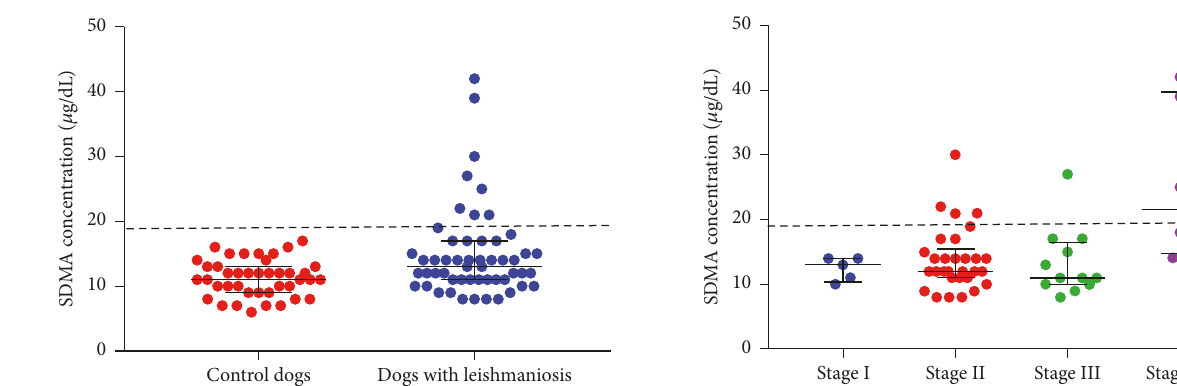
Figure 2: Distribution of SDMA concentrations in 53 dogs with leishmaniosis on the day of diagnosis (blue dots) and 41 control dogs (red dots). The large black bar indicates the median of each group and the whiskers indicate the interquartile range. The dashed line indicates SDMA concentration of 19 𝜇 g/dL.